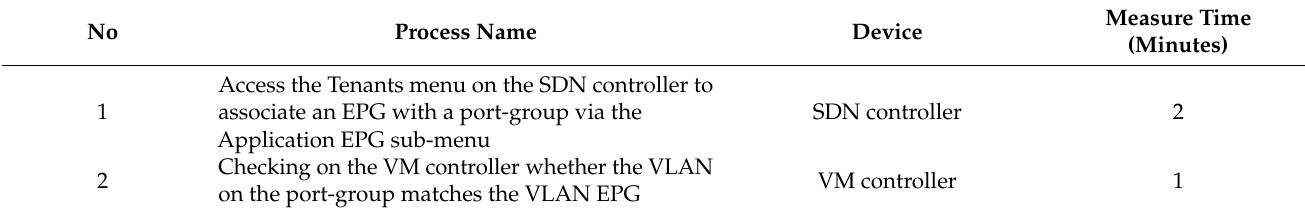
Table 13. EPG association measurement time with port-group.